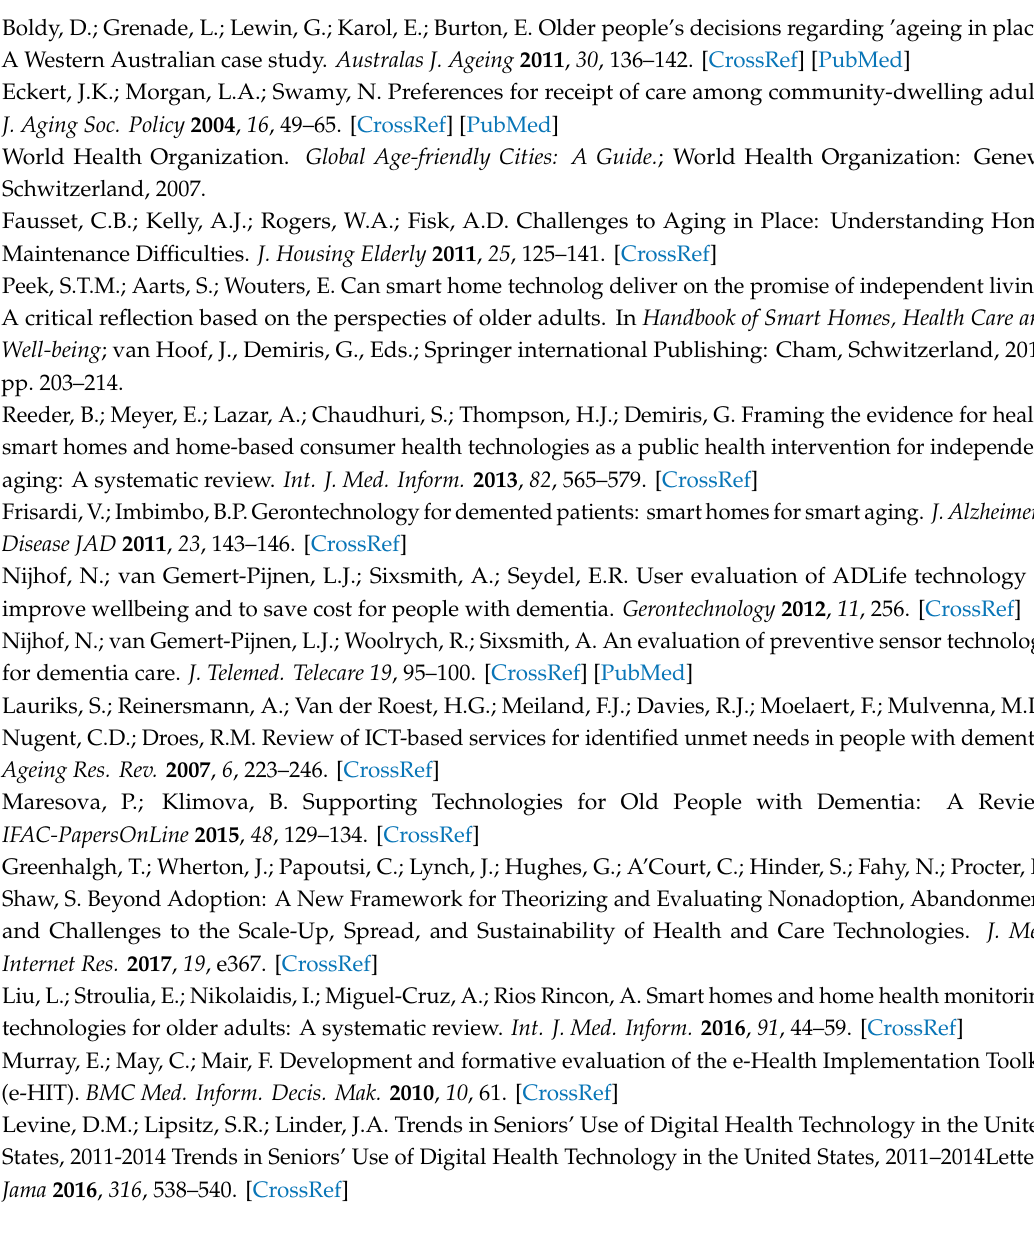
Table S1: Features of primary studies, Table S2: Results of perspectives of stakeholders per